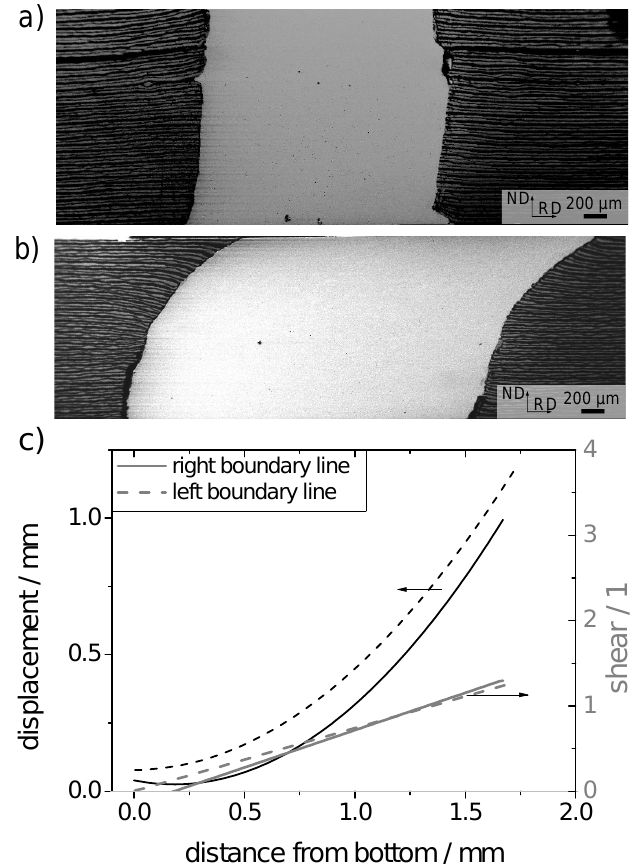
Figure 8. Shear deformation imaged by a Cu-pin inserted into a 160-layered Ti/Al composite. This Cu-pin shows no shearing in the case of conventional rolling ( a ); whereas DSR yields considerable shear ( b ); The left (dotted lines) and right (straight lines) boundaries between the Cu-pin and the Ti/Al-composite have been used to evaluate the relative position of the material as shown in the right chart ( c ). The grey lines represent the calculated amount of shear